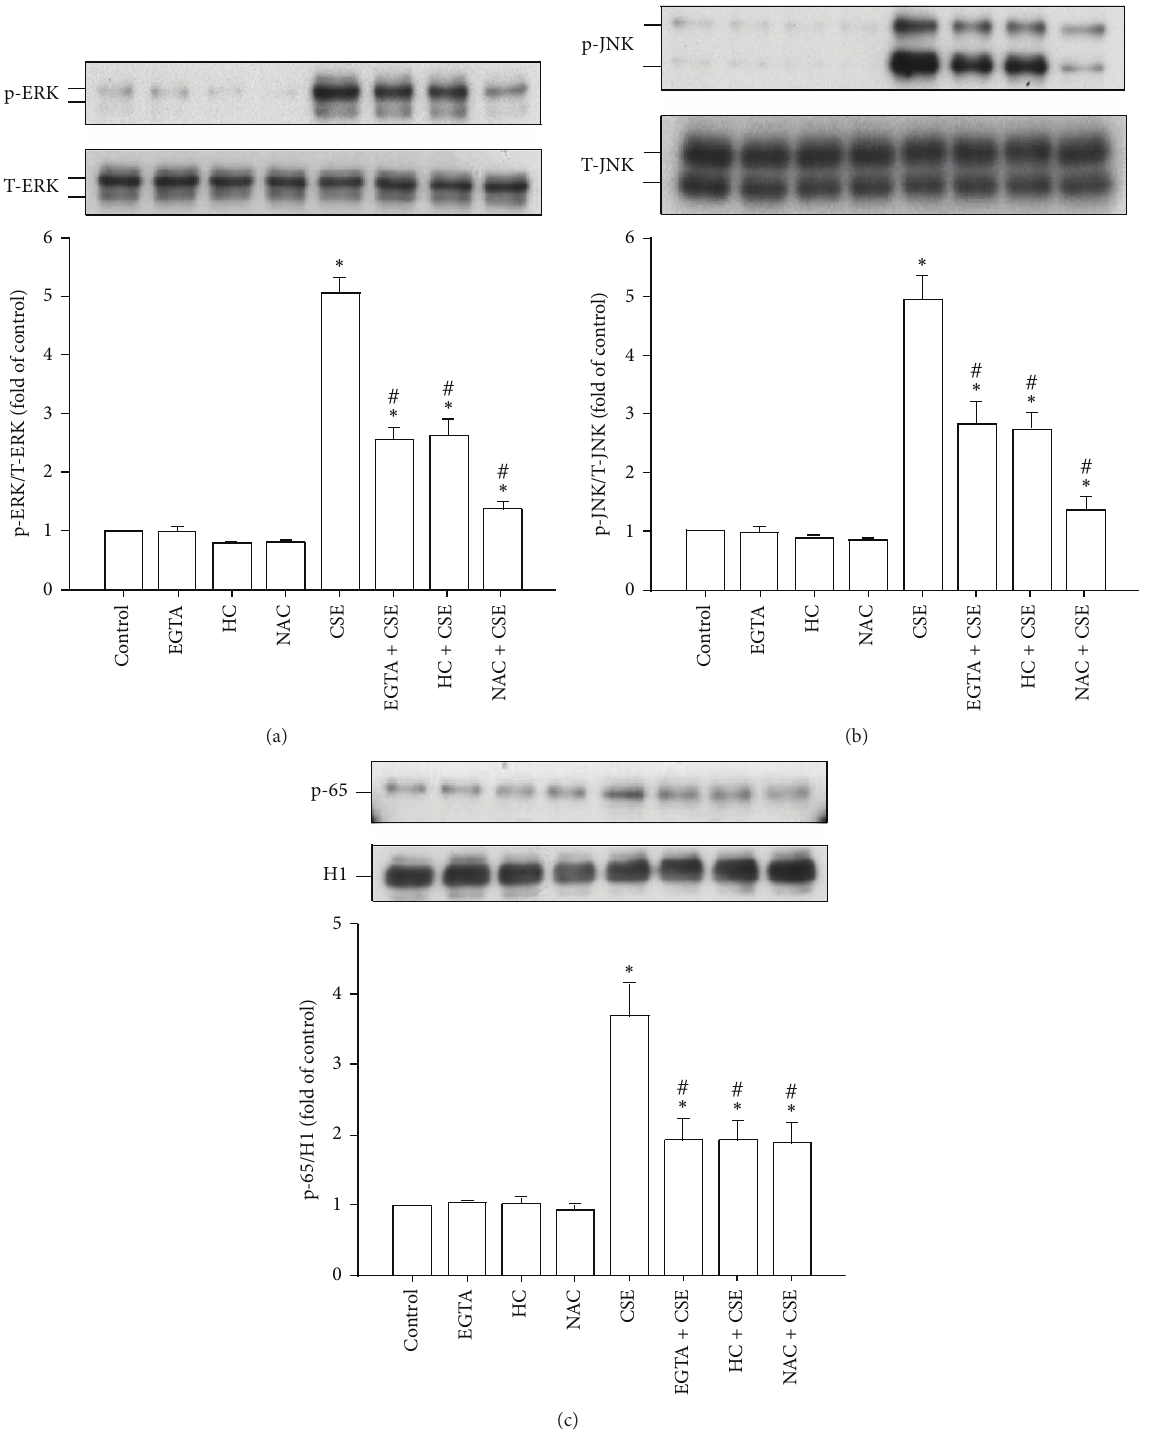
Figure 5: The CSE-induced activation of the ERK/JNK/NF- 𝜅 B signaling in HBECs is TRPA1-mediated, Ca 2+ -dependent, and ROS-sensitive. (a–c) Cells were exposed to medium alone or to 3% CSE for 6, 6, and 12h, respectively, and pretreated with EGTA (an extracellular Ca 2+ chelator; 500 𝜇 M), HC-030031 (HC, a TRPA1 antagonist; 9 𝜇 M), or N-acetyl-cysteine (NAC, a ROS scavenger; 1mM). Protein expression was analyzed by Western blotting. Activation of ERK and JNK was indicated by increased phosphorylation of these kinases, whereas activation of NF- 𝜅 B was indicated by the increased presence of p65 subunit in the nucleus. Data in each group are mean ± SEM from five independent experiments. ∗ 𝑝 < 0.05 versus the control; # 𝑝 < 0.05 versus CSE